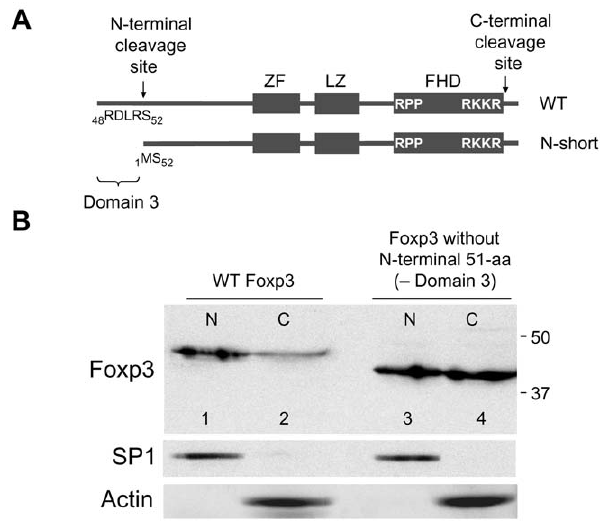
Figure 5. N-terminal 51-aa of Foxp3 (Domain 3) contribute to its nuclear translocation. A. Schematic diagram of WT Foxp3 and of Foxp3 missing the N-terminal 51-aa (N-short). B. Western blot showing the nuclear and cytoplasmic distribution of WT and N-short Foxp3. The reduced size of N-short Foxp3 (41-kDa) in lanes 3 and 4 is due to the absence of N-terminal 51-aa. CD4 + cells were harvested 20 hr after transduction. Lower panels, SP1 and Actin controls.